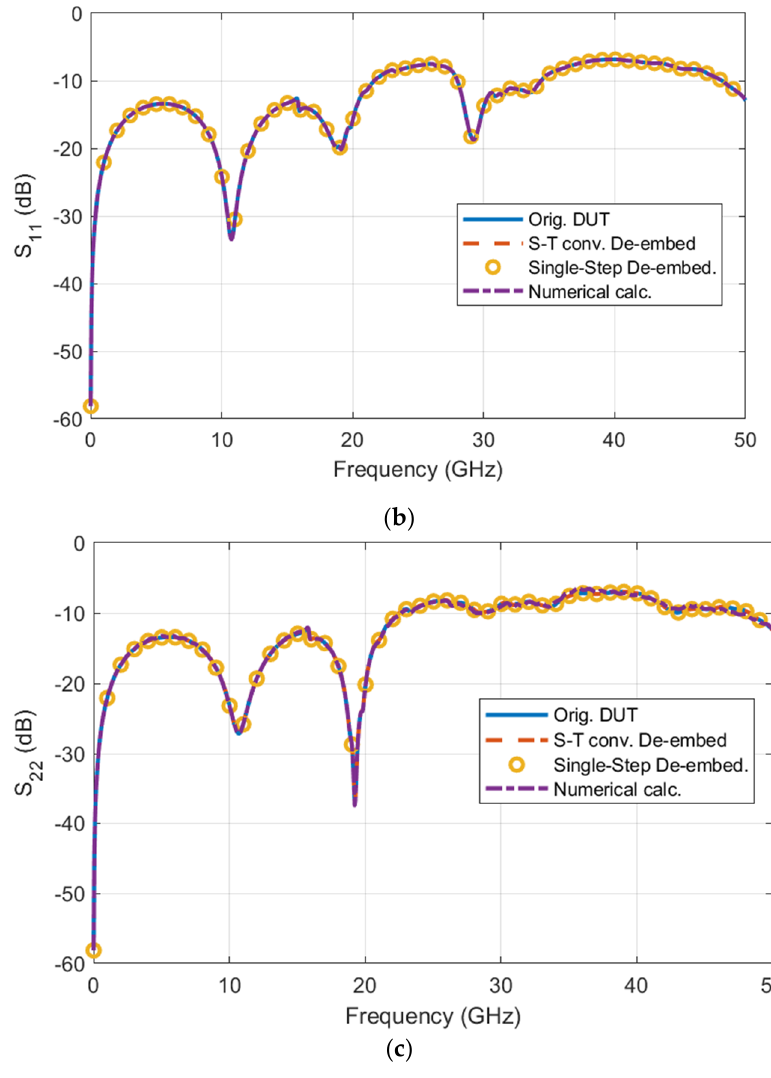
Figure 4. Comparison of the S-parameters obtained by: 1. the standalone original device under test (DUT) considered as reference (continuous line “Orig. DUT”), 2. the classic standard two-steps S-to-T and T-to-S parameter conversion (dashed line “S-T conv. De-embed”), 3. the single-step procedure (circles “Single-Step De-embed.”) and 4.by the numerical iterative solution (dash-dot line “Numerical calc.”). ( a ) S 21 , ( b ) S 11 , ( c ) S 22 .